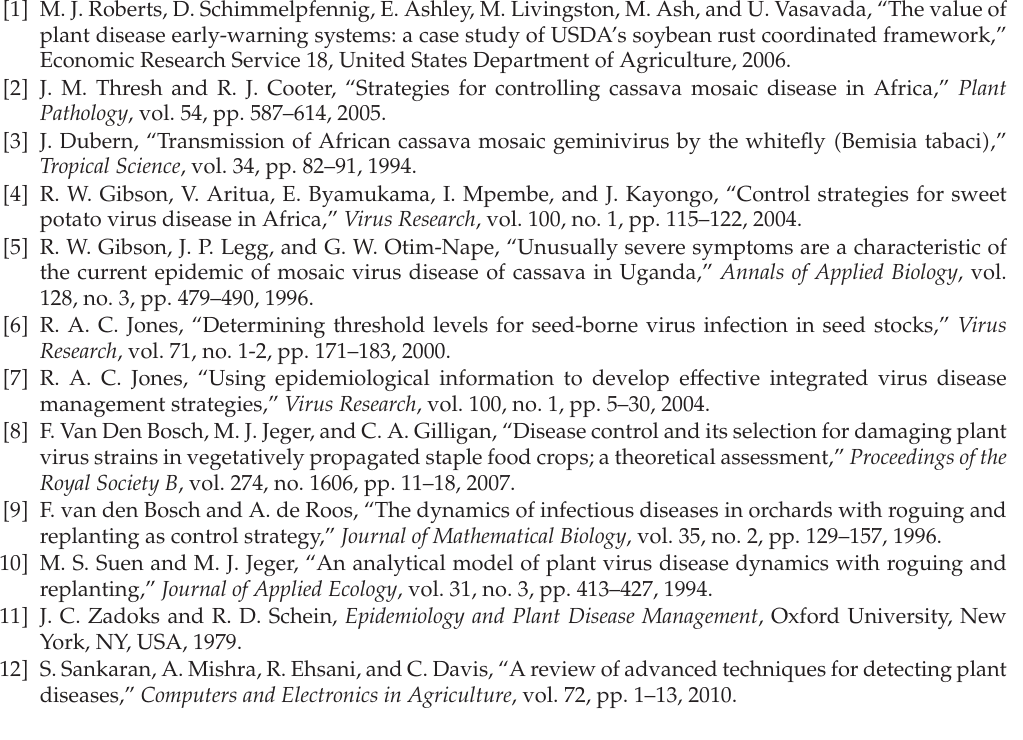
ρ ∗ (cid:7) (cid:3) e μT − 1 (cid:4)(cid:3) μ (cid:3) d (cid:8) r (cid:8) ω (cid:4) / (cid:3) βe − μτ − α (cid:3) d (cid:8) r (cid:8) ω (cid:4)(cid:4)(cid:4) . We think that our results will o ff er help to the actual plant infectious disease